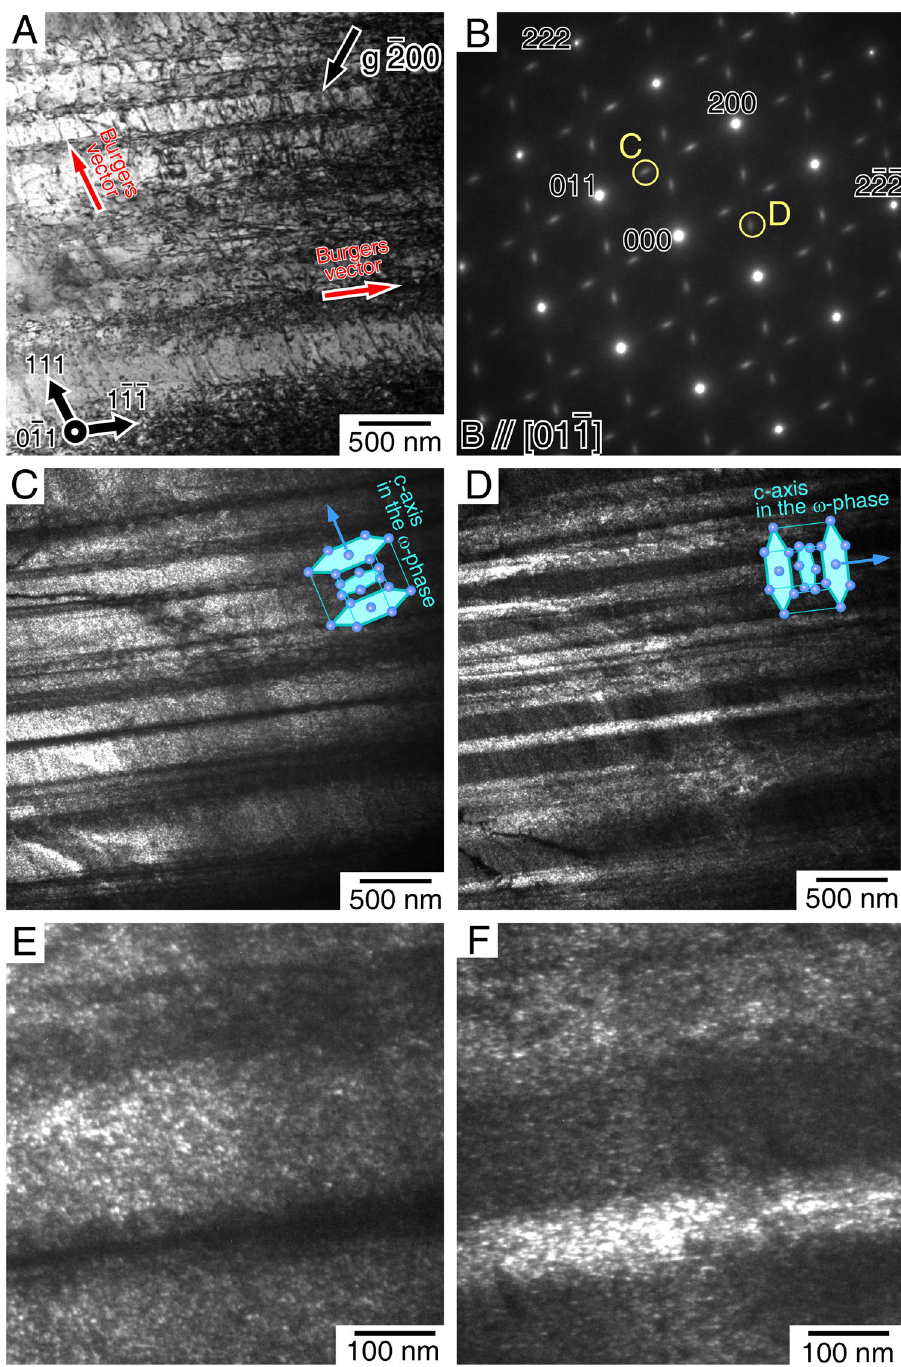
Figure 3. Formation of two ω -phase variants in the specimen in which two kinds of dislocations are operative. ( A ) Dislocation morphology in the specimen cyclically deformed at the [012] orientation at Δε /2 = 1.1% to ~830 cycles. Beam//[01 1 ]. Two kinds of dislocations with the Burgers vector parallel to [111] and [ 1 11] were observed to be operative as screw dislocations. ( B ) SAED pattern in the cyclically deformed specimen. The extra spots used for dark-field observations shown in Fig. 3C,D are denoted by the yellow circles. ( C , D ) Dark-field images showing the ω -phases observed in the same area shown in Fig. 3A. Two kinds of ω -phases appeared in separate regions, obviously following the dislocation distribution. ( E,F ) Higher magnification images of the precipitated ω -phase particles shown in Fig. 3C and D,